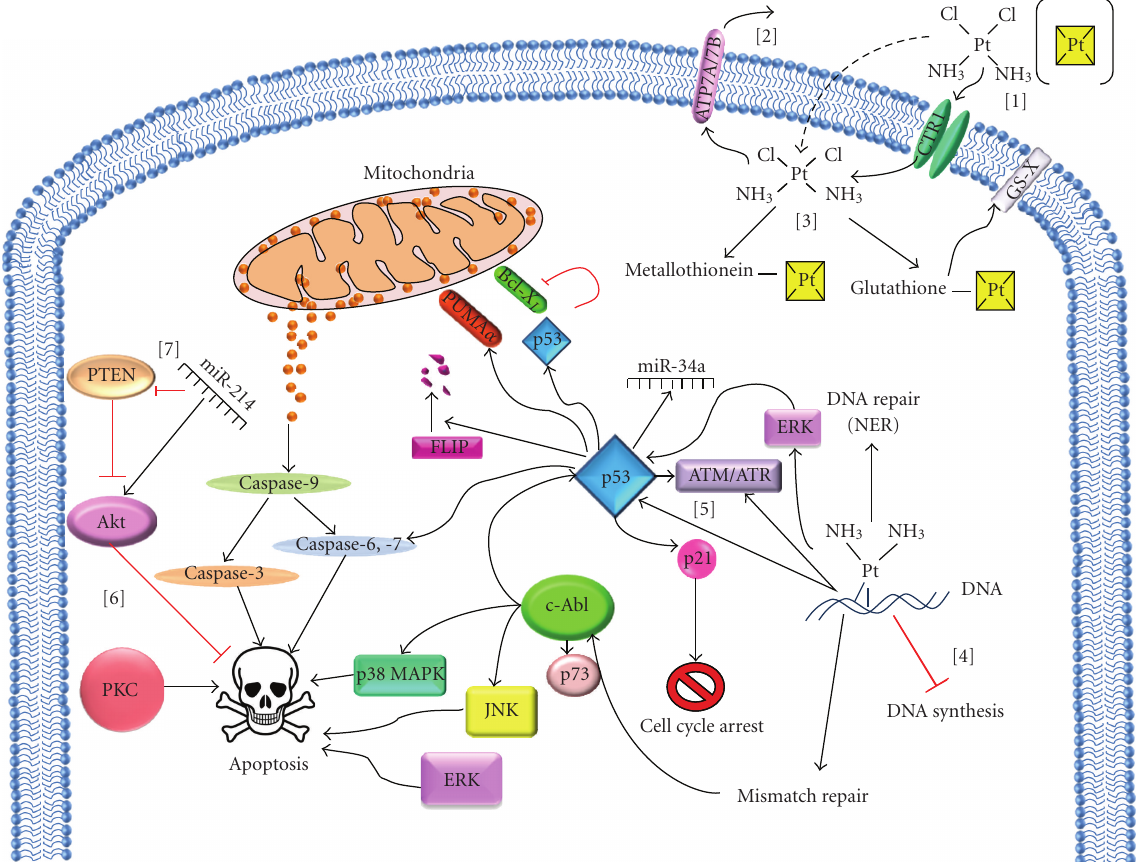
Figure 1: Cellular responses to cisplatin-induced DNA damage. [1] Entry of cisplatin into cells by passive di ff usion (indicated by dotted arrows), carrier-mediated transport, employing copper transporter-1 (CTR1). [2] E ffl ux of cisplatin from the cells by the